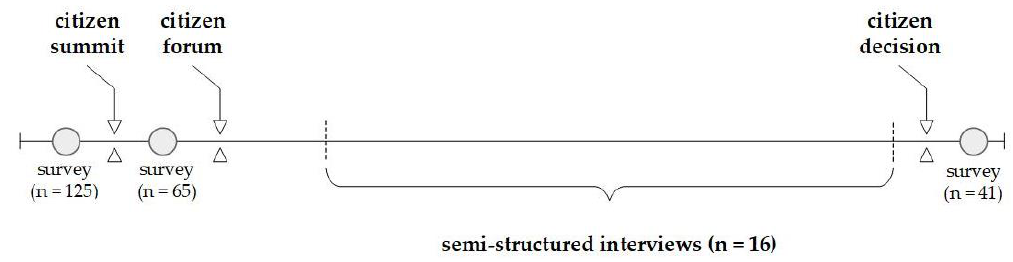
Figure 2. Three sources for qualitative data collection process.